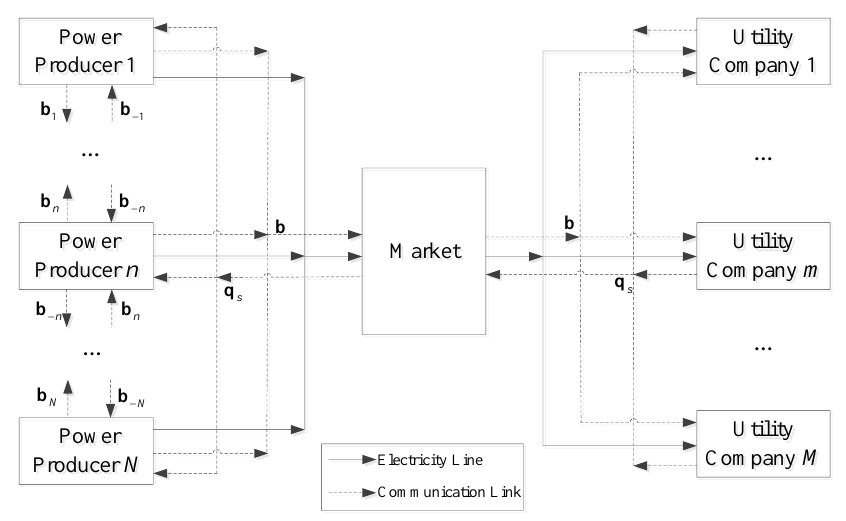
Figure 1. Generation side bidding transaction